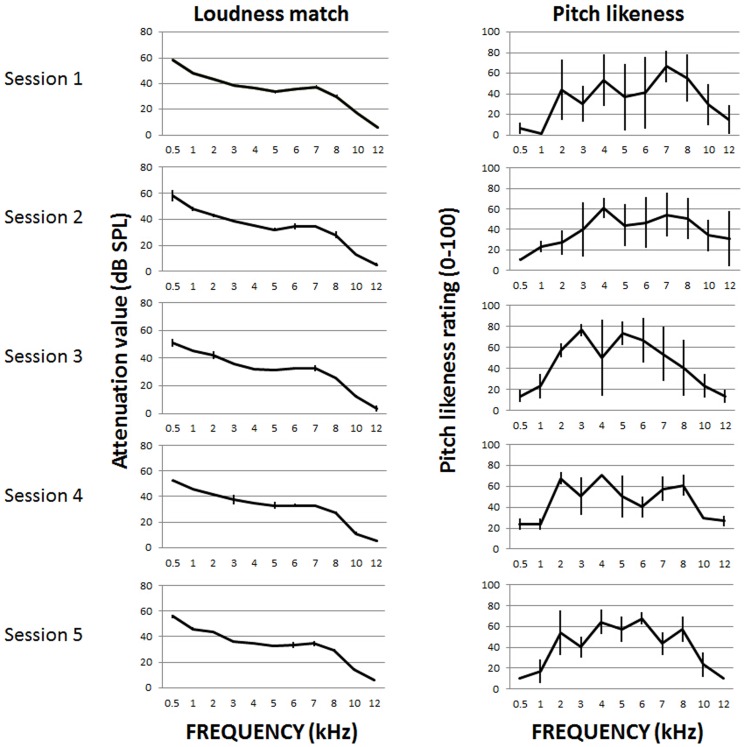
Example data from a Study 1 participant with tonal tinnitus.In Step 3 of the ‘Tinnitus Tester’ participant always selected ‘Tonal’. Data are presented as mean ± SD for each test frequency. Loudness match is reported as the PA5 attenuator value, 0 attenuation (maximum output of the system) was 96 dB SPL.